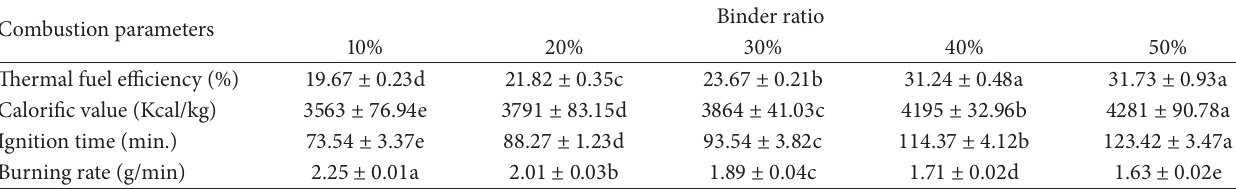
Table 4: Combustion characteristics of water hyacinth briquettes and binder proportions. Combustion